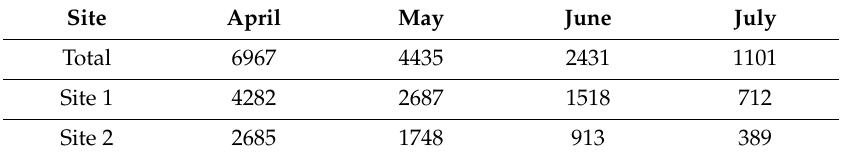
Table 1. Monthly wellbeing centre attendance by site during April–July 2020.